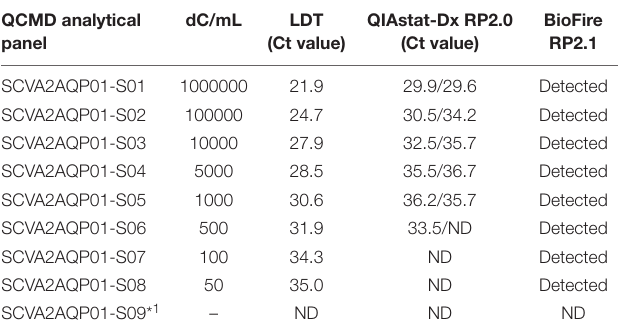
TABLE 1 | Analytical sensitivity of the QIAstat-Dx RP2.0 and BioFire RP2.1 for SARS-CoV-2. QCMD analytical dC/mL BioFire panel